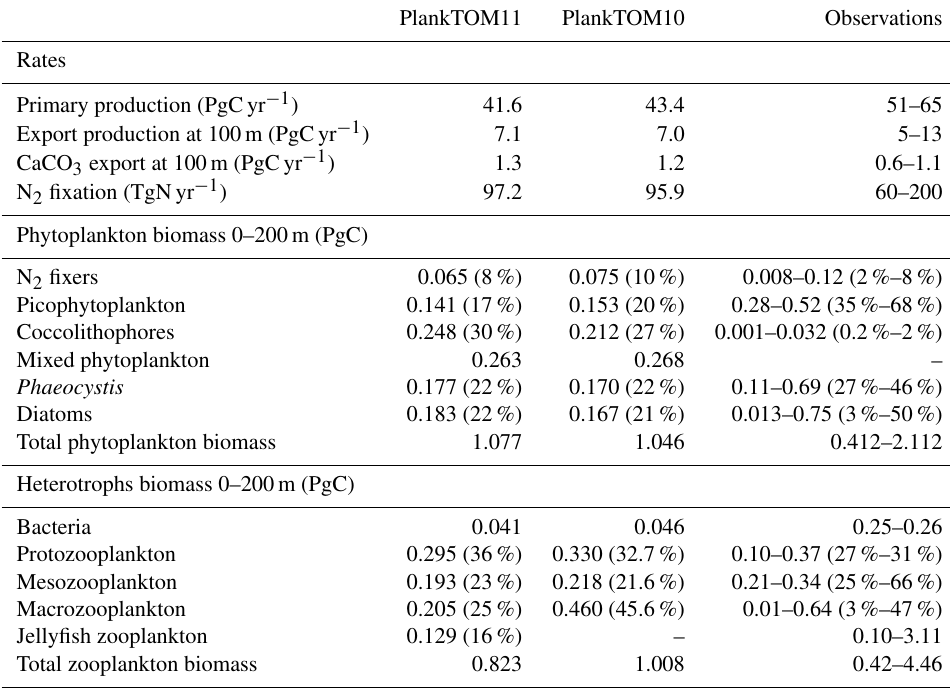
Table 6. Global mean values for rates and biomass from observations and the PlankTOM11 and PlankTOM10 models averaged over 1985– 2015. In parenthesis is the percentage share of the plankton type of the total phytoplankton or zooplankton biomass. The percentage share of mixed phytoplankton is not included, as there are no mixed-phytoplankton observations; therefore, the phytoplankton percentages are of total phytoplankton minus mixed phytoplankton. References for observations are given in Appendix Table A5.